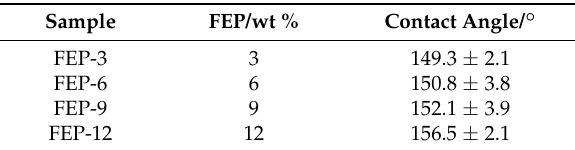
Table 1. Static contact angle values of gas diffusion media (GDM) with different fluorinated ethylene propylene (FEP)